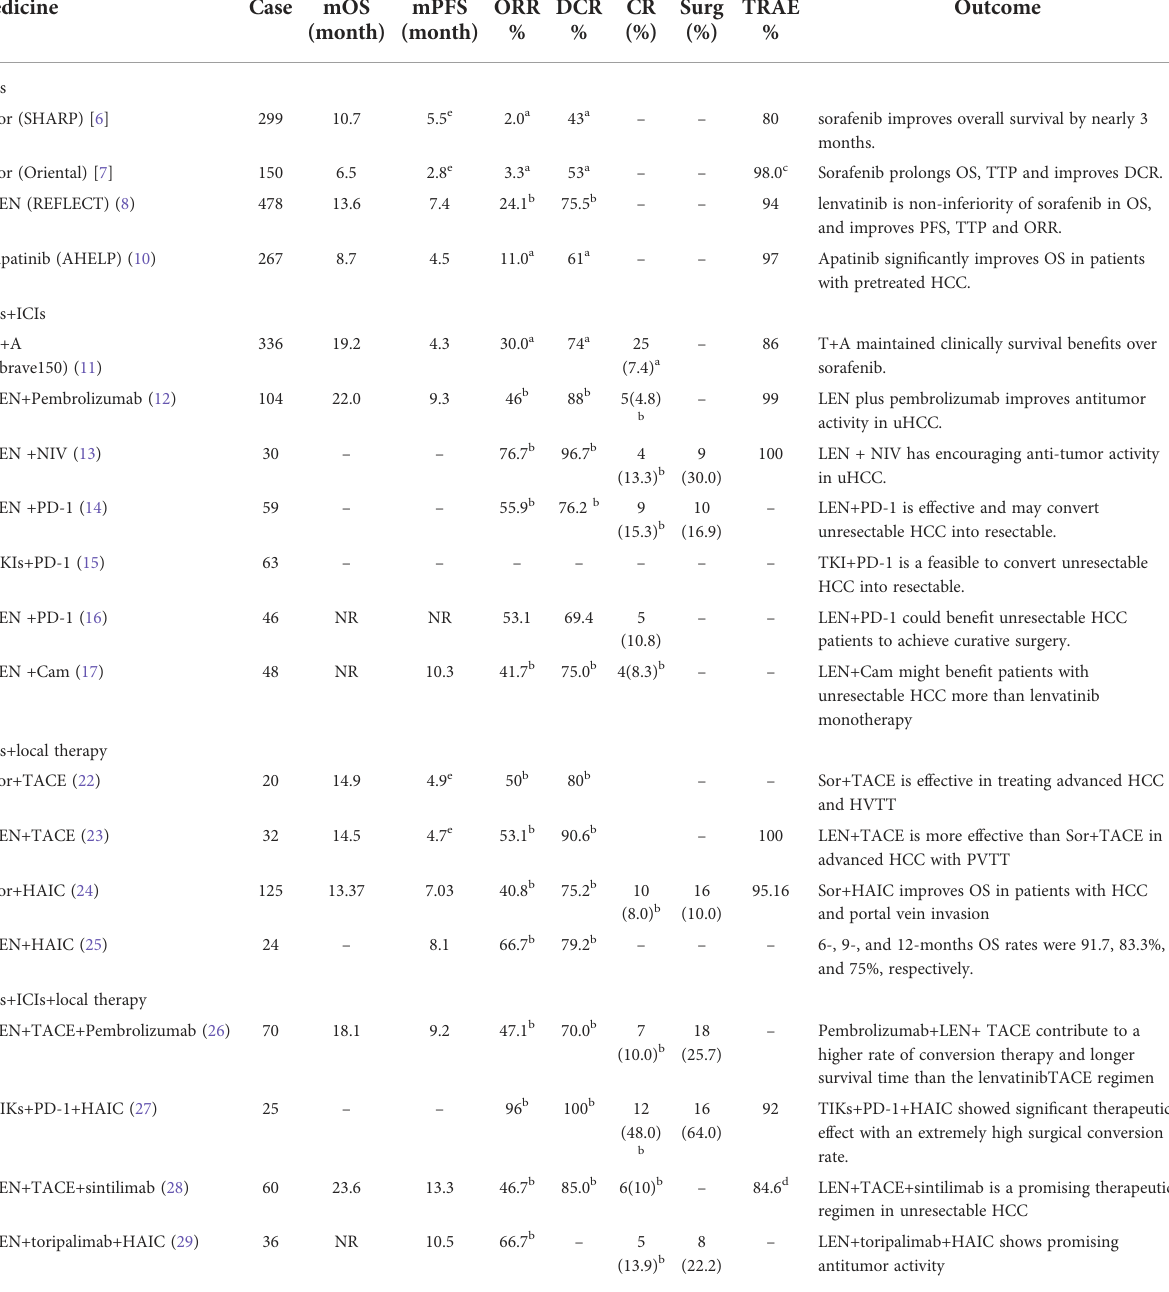
TABLE 1 Clinical studies of conversion therapy in unresectable HCC